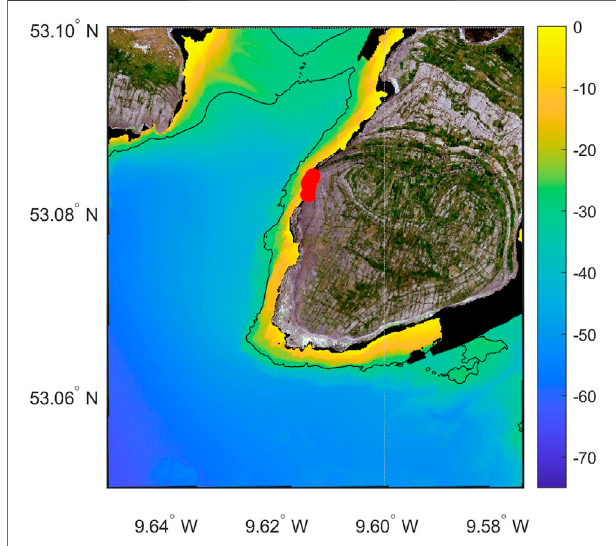
FIGURE 4 | The western side of Inishmaan was the location of the only CBD present at Z* > 2.5 on all the islands (red circles, N (cid:1) 7). Bathymetry (m) and the 30 m depth contour are given as